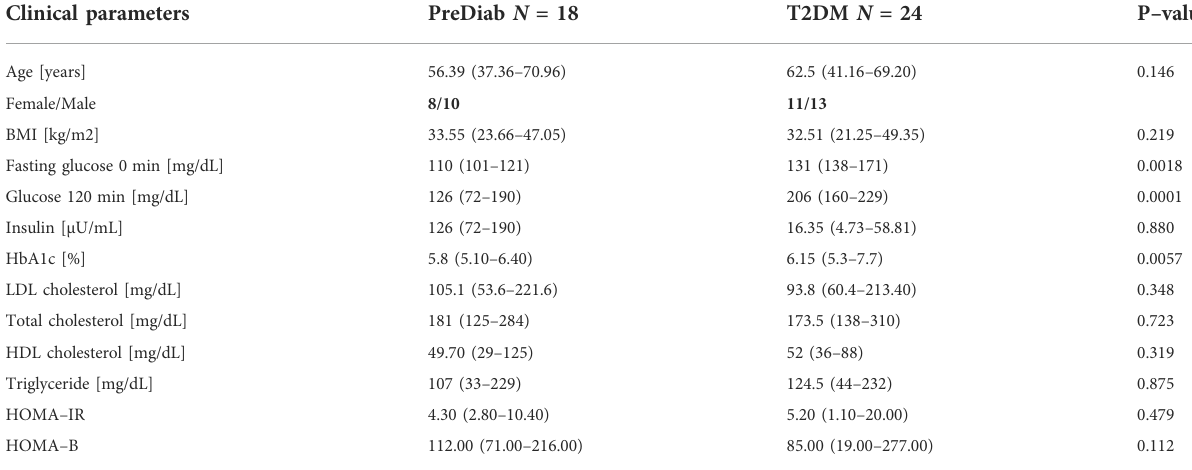
TABLE 1 Characteristics of the studied group (median and